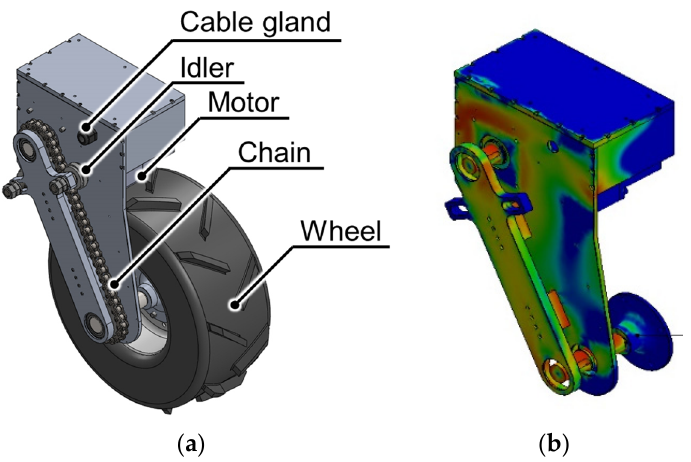
Figure 3. ( a ) CAD, ( b ) Result of Finite Element Method. CAD of a developed running